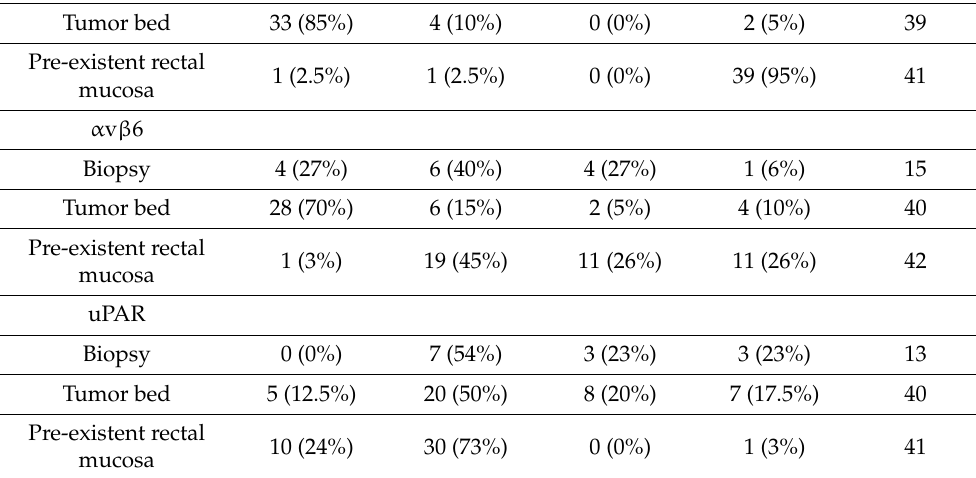
Total Immunostaining Score (TIS) on Biopsy, pCR Tumor Bed, and Pre-Existent Rectal